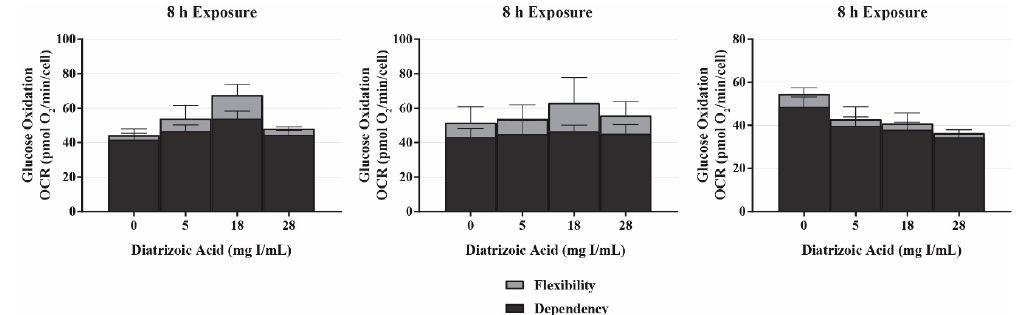
Figure 6. Diatrizoic acid e ff ects on mitochondrial fuel oxidation in HK-2 cells. DA did not a ff ect mitochondrially-linked oxidation of glucose, glutamine, and fatty acids in response to 8 h exposure. Values represent mean ± SEM for three independent